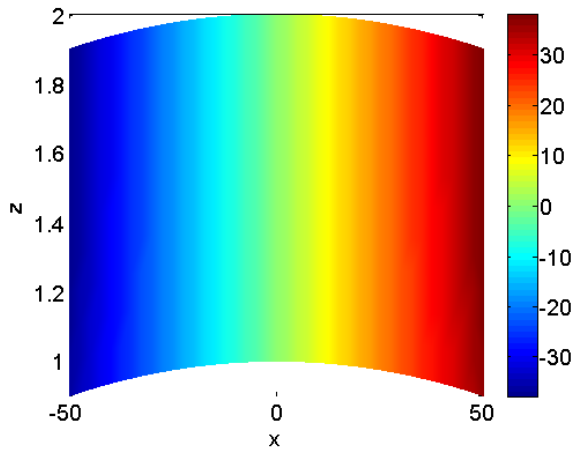
Figure 4. Contour plot of the exact solution to the x – z MMS test case.